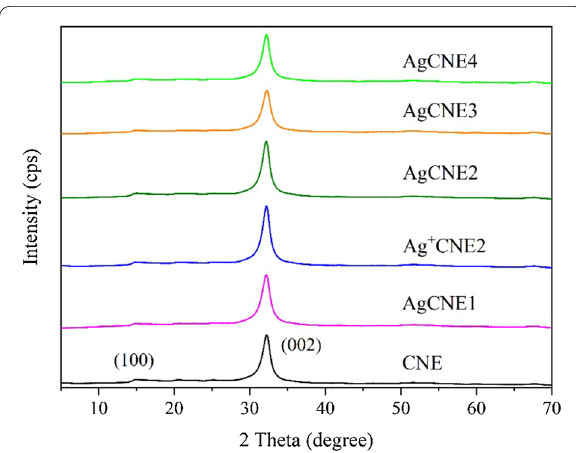
Table 2 Two main diffraction peaks, crystallite sizes and